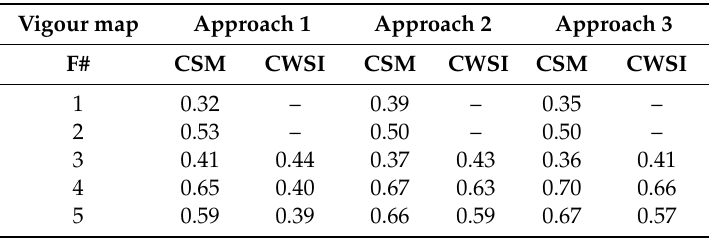
Table 2. Quantitative comparison using the local Moran’s index of the normalized di ff erence vegetation index (NDVI) vigour classes in the three di ff erent approaches considered to the crop surface model (CSM) and crop water stress index (CWSI) classes with a p -value < 0.001, for each flight campaign (F#). Vigour map